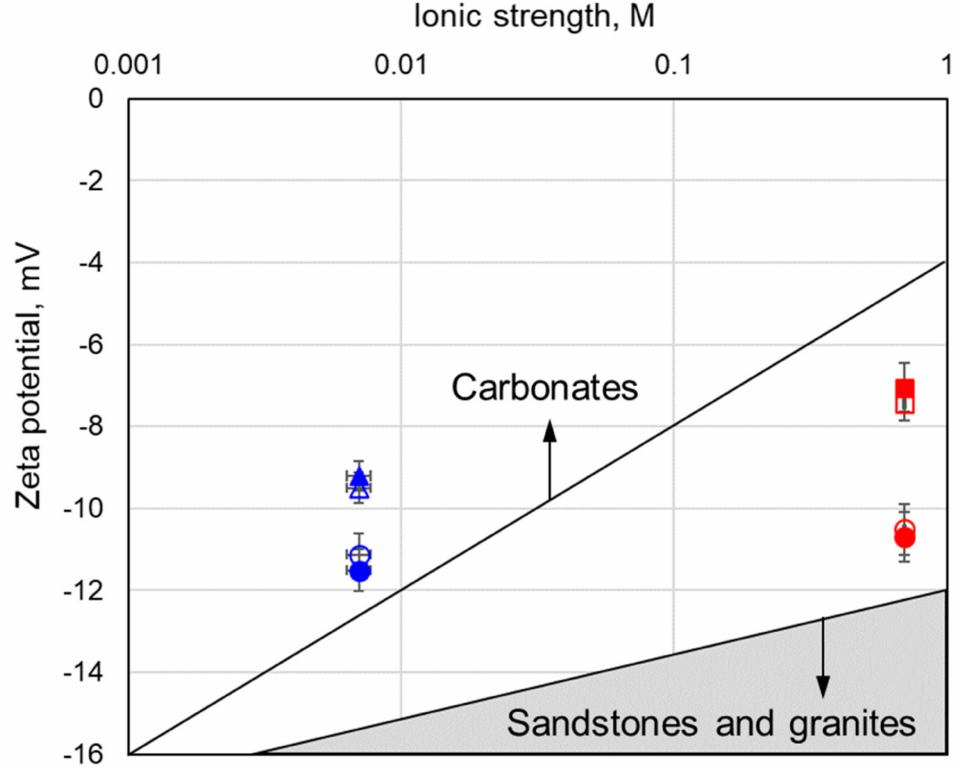
Figure 2. Zeta potential of gneiss samples compared with published data on other types of rocks. Circles denote NaCl solutions, triangles correspond to AGW and squares are ASW. Filled symbols correspond to confining pressure of 7 MPa. Low ionic strength is denoted by blue symbols while the high ionic strength data corresponds to red symbols. The solid lines that outline domains of reported data for carbonates and sandstones are based on the published data summarized in Table 2. Table 2. Summary of experimentally measured zeta potential in relevant samples saturated with NaCl and natural solutions. In the table, LS and HS correspond to low-salinity and high-salinity data, SS stands for sandstones, SP corresponds to sand packs, LS refers to limestones, SW is natural seawater from southern UK, TW is tap water and ALSW is artificial low-salinity water. Exact values of ionic strength in the table vary between 0.001 M and 0.01 M for low salinity, and between 0.5 M and 0.75 M for high-salinity data. For details, refer to the cited papers. The data sources are: a—Vinogradov et